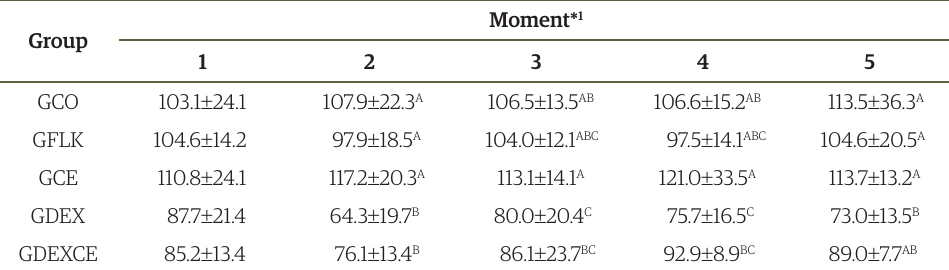
Table 2. Heart rate (HR) values (bpm) between moments in the groups.